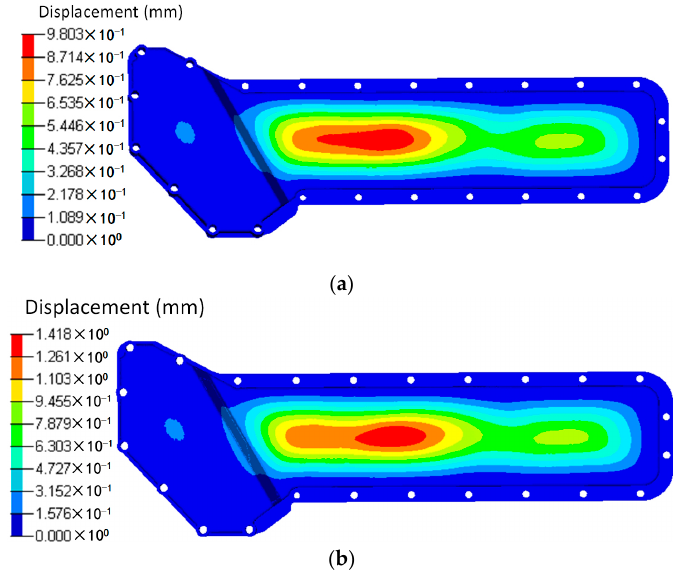
Figure 13 . Displacements of ( a ) the isotropic and ( b ) the orthotropic oil cooler covers under distributed pressure.